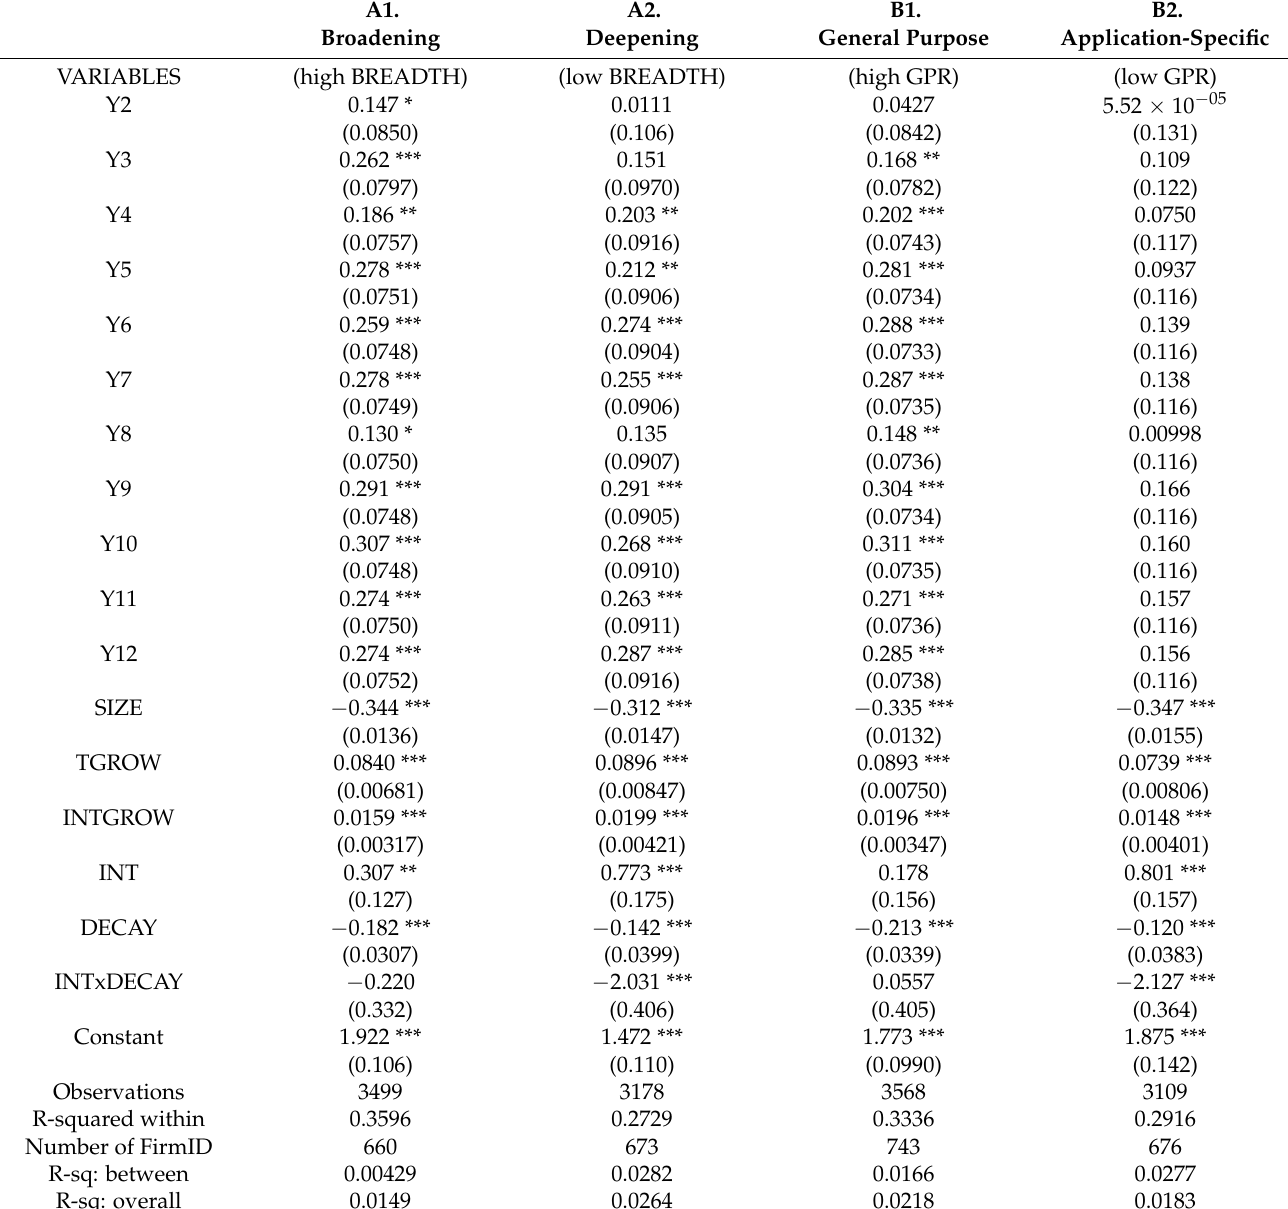
Table 9. Intangible intensity and decay within contexts of different intangible types (growth): regressions. A1. Broadening